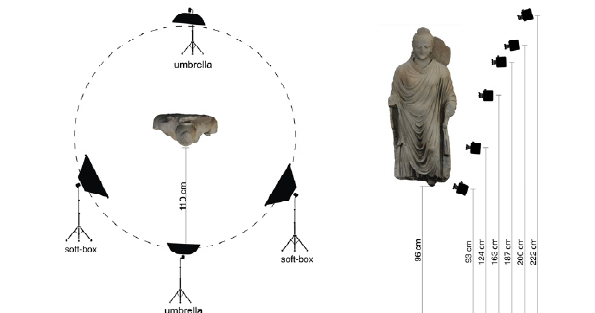
Figure 5 . North and East elevations of Gumbat (after the end of the excavations; 2011).